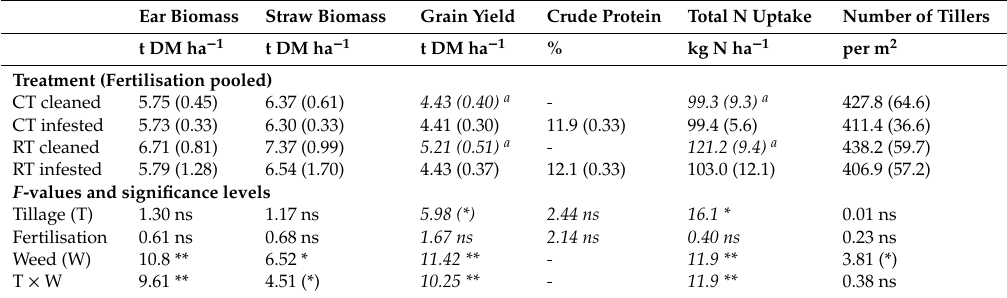
Figure 2. Total wheat biomass (g dry matter m − 2 ) per tillage system and weeding treatments at different wheat stages. Fertilisation treatments were pooled. CT = ploughing, RT = reduced tillage. Table 2. Mean (standard deviation) and statistical results of the effect of tillage system and weeding treatments on wheat parameters assessed at harvest.